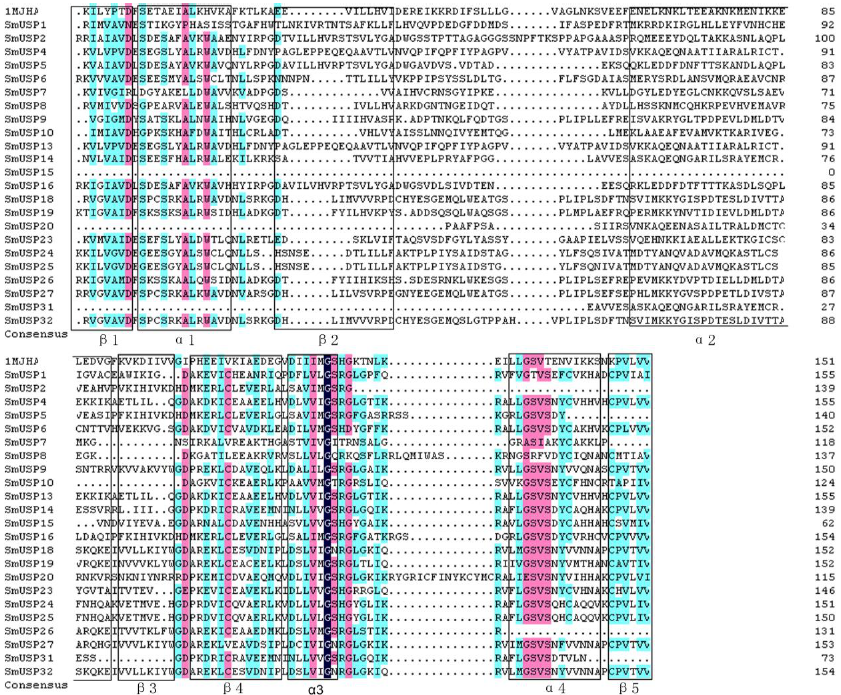
Figure 3. Multiple sequence alignment of 21 SmUSPs and USP MJ0577 (1MJH). The secondary structures involved in ATP-binding function of SmUSPs are marked below sequences according to structure of MJ0577 (1MJH).